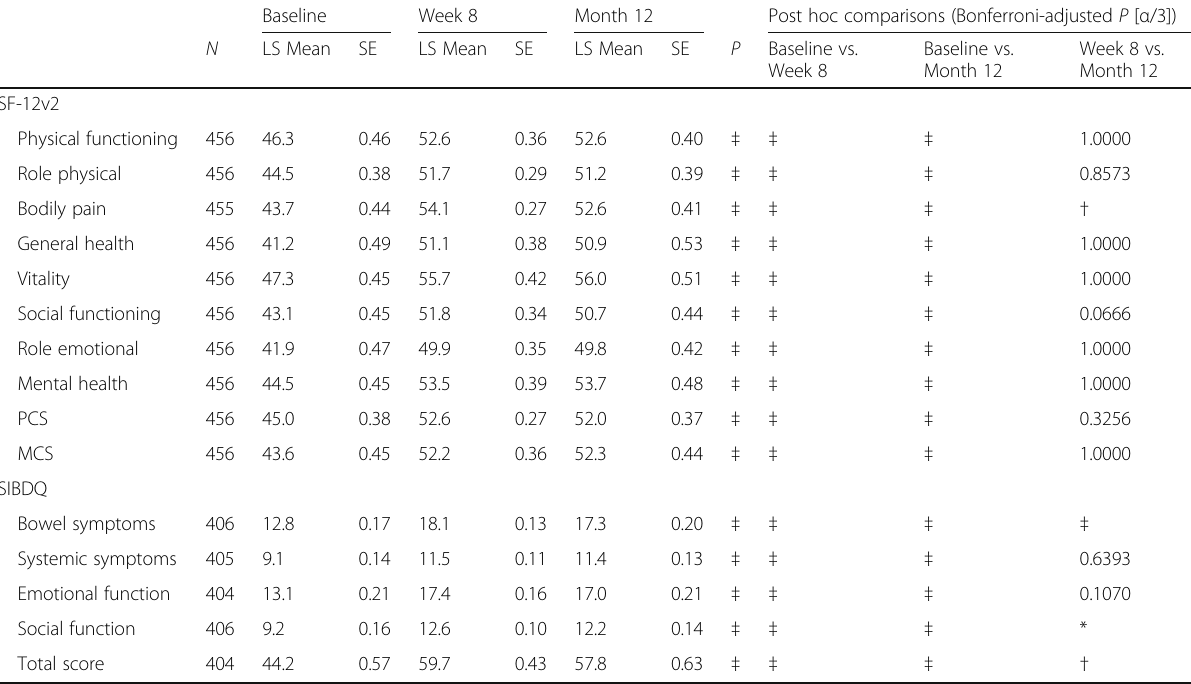
Table 4 SF-12v2 and SIBDQ scores for the maintenance phase sample at acute and maintenance phase